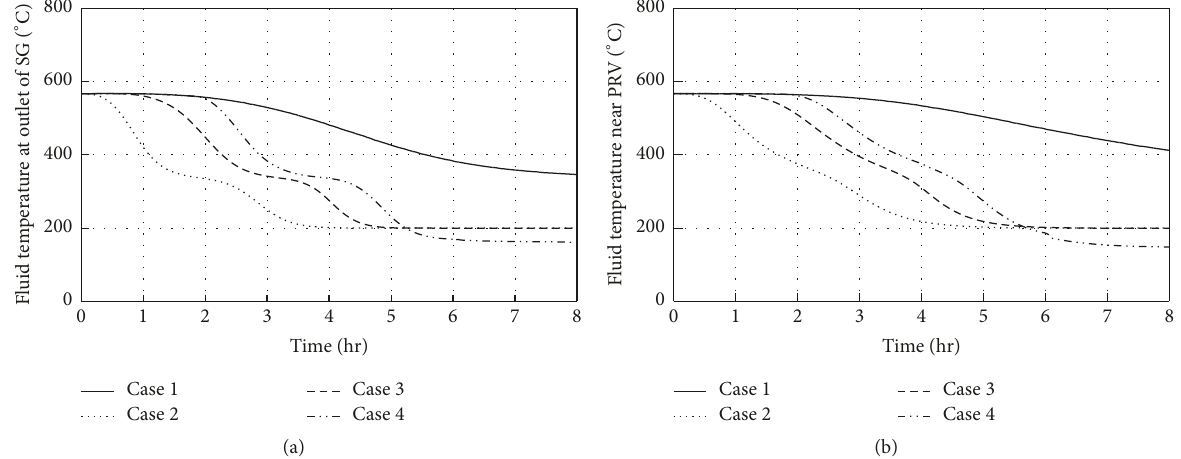
Figure 5: Fluid temperature at different locations during precooling injection.